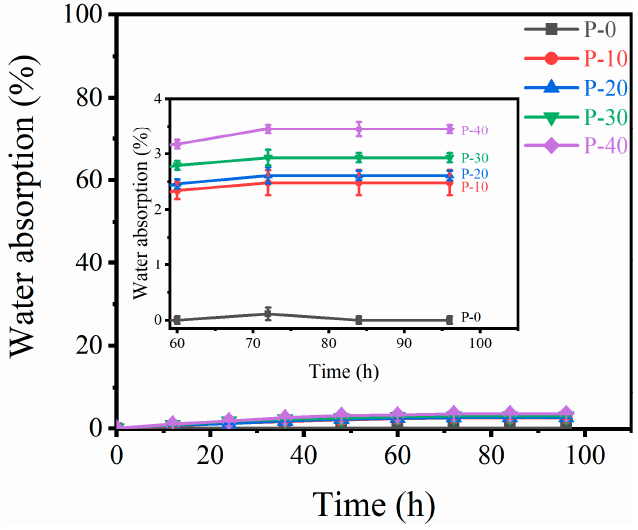
Figure 5. Water absorption properties of PP − g − PHMG/PP − blended monofilaments.